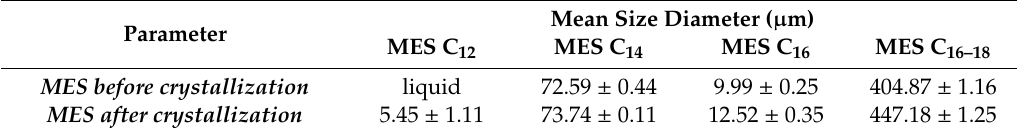
Table 5. Particle size of MES surfactant.